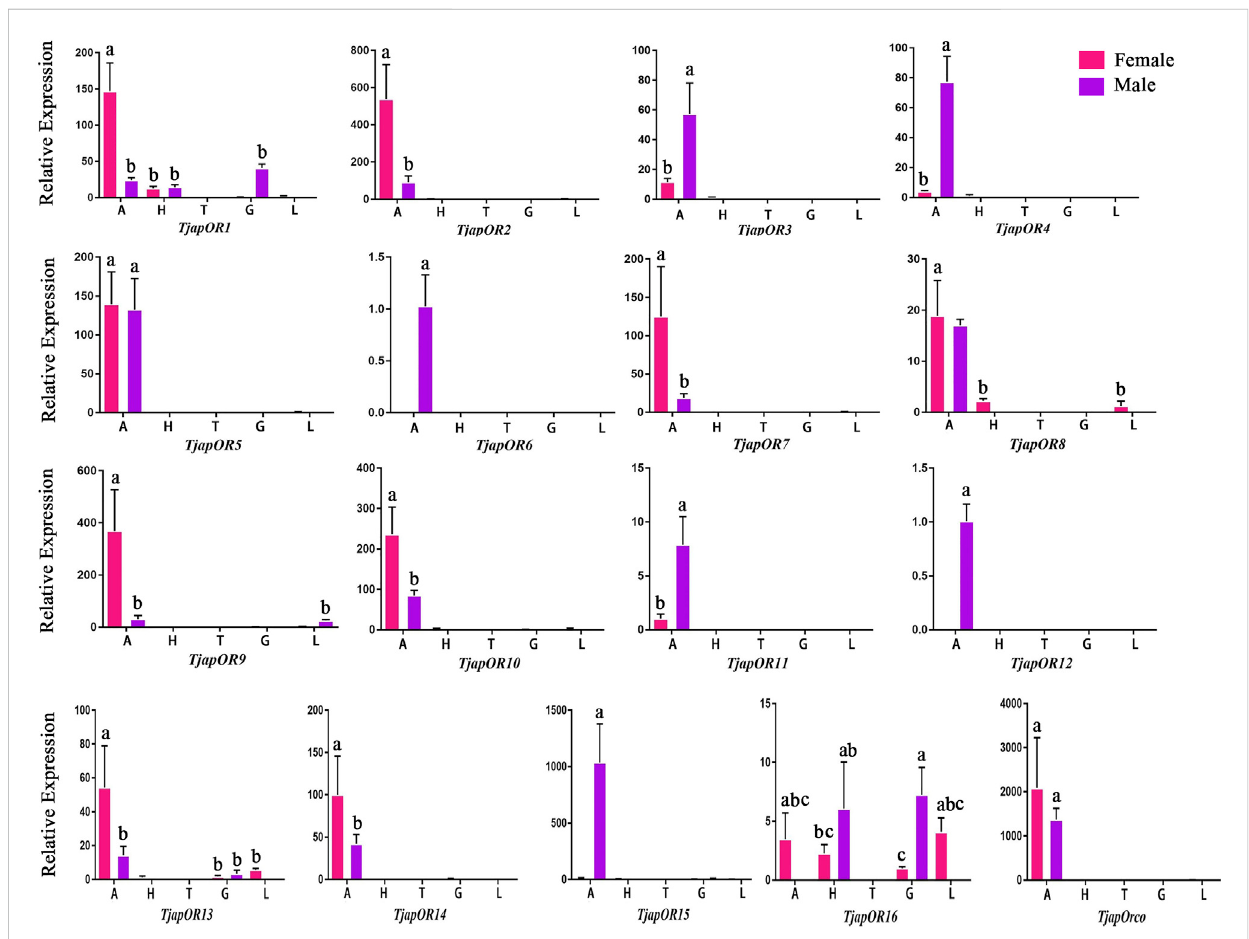
FIGURE 11 Expression pro fi les of T. japonensis ORs in different tissues of female and male. A: antennae; H: heads (without antennae); T: thoraxes; G: external genitals; L: legs. The letters above the error bar denote signi fi cant differences ( p <